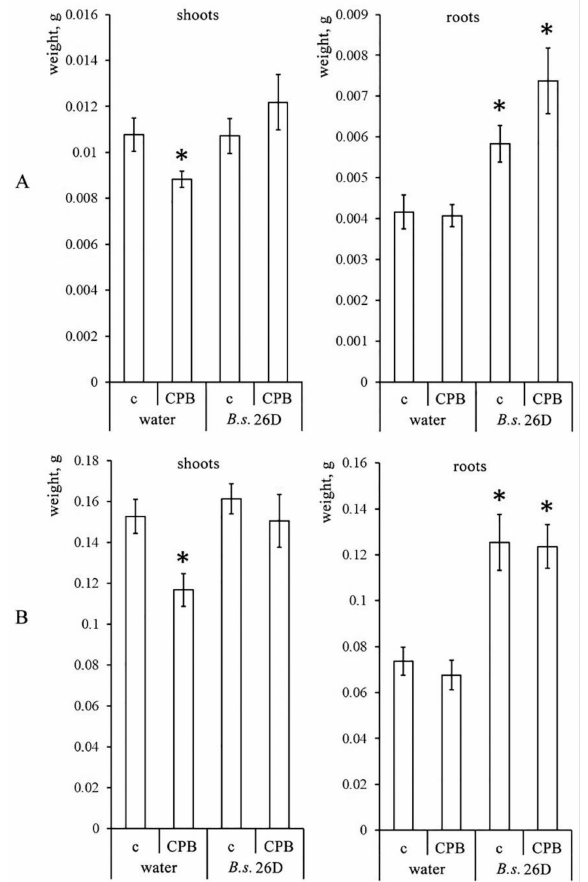
Figure 2. Influence of B. subtilis 26D on fresh ( A ) and dry ( B ) weights of shoots and roots of potato plants on the 9th day post damage caused by CPBs. The values are means, and the vertical bars represent standard errors. Data analyzed using two-way ANOVA with Tukey’s post hoc test. Asterisks indicate means statistically different from the control at p ≤ 0.05. c—control plants (water-treated intact plants); CPB—plants damaged by Colorado potato